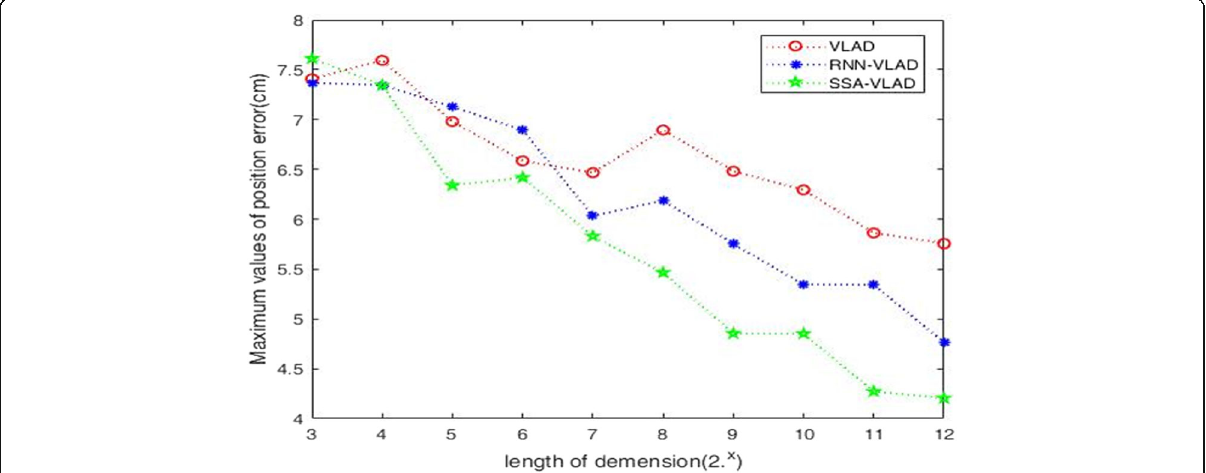
Fig. 4 The maximum values of position error with different lengths of dimension legend: The x -axis denotes the dimension length, and the y -axis denotes the maximum values of position error